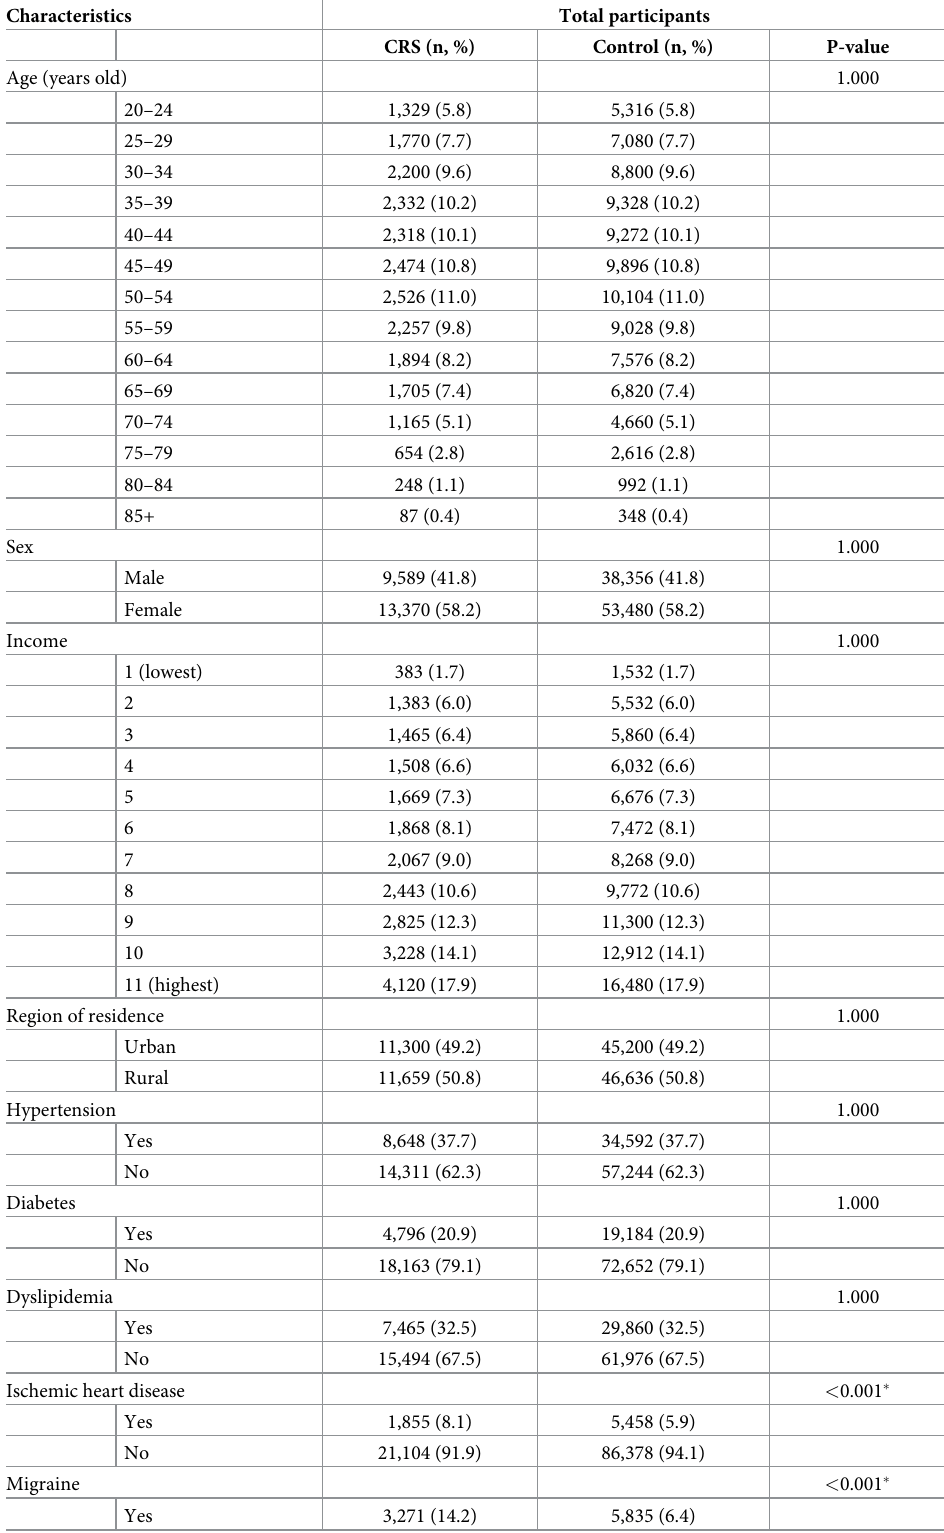
Table 1. General characteristics of